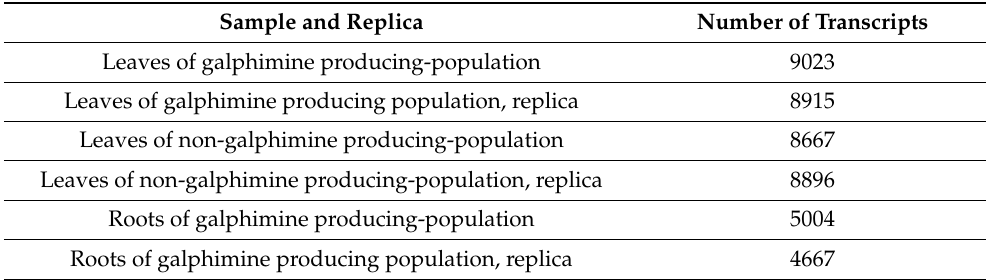
Table 1. Transcripts were obtained after de novo assembly of